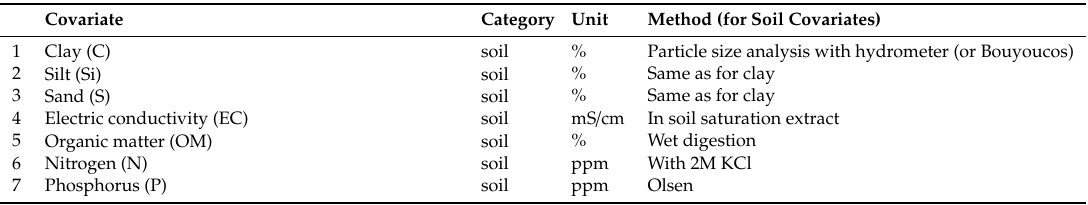
Table 1. Covariates used in the